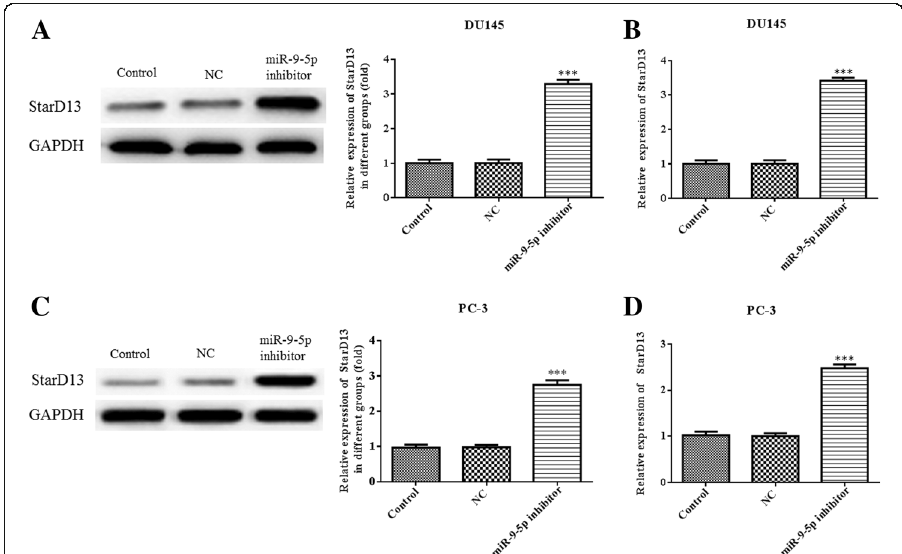
Fig. 10 The expression levels of StarD13 in DU145 and PC-3 cells transfected with an miR-9-5p inhibitor. The protein ( a ) and mRNA ( b ) expression levels of StarD13 in DU145 cells with miR-9-5p inhibitor or NC transfection were determined, respectively using quantitative RT-PCR or western blot. The protein ( c ) and mRNA ( d ) expression levels of StarD13 in PC-3 cells with miR-9-5p inhibitor or NC transfection were determined, respectively using quantitative RT-PCR or western blot. *** p < 0.001 vs. NC group. All experiments were performed with at least three